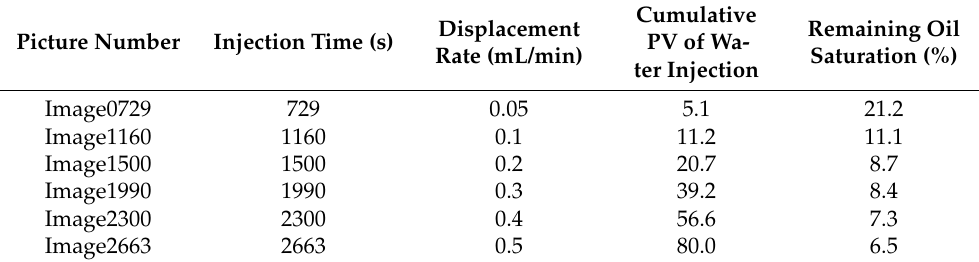
Table 3. Cumulative PV numbers of water injection and remaining oil saturation calculation results.